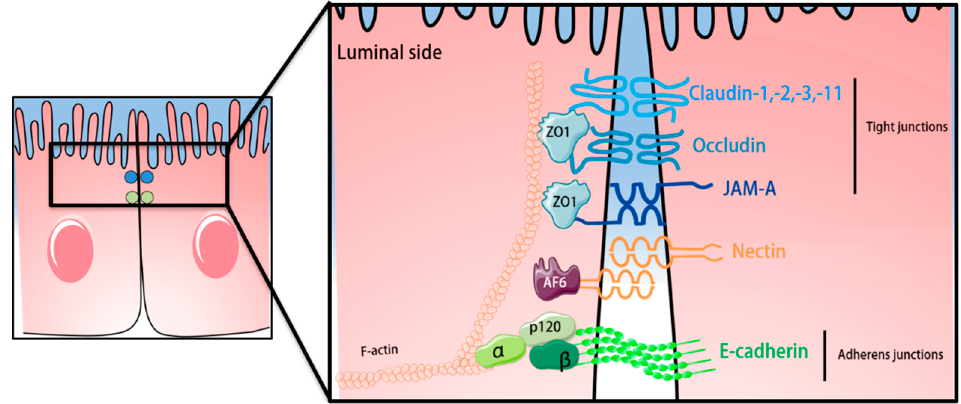
Figure 3. Schematic representation of the junctional complexes of the BCSFB at the choroid plexus. In similarity to the BBB, the proteins that compose the tight and adherens junctions of the choroid plexus BCSFB are connected to the cytoskeleton via intracellular scaffolding proteins and are localized in the apical part of the choroid plexus epithelial cells. The shapes of the proteins were adapted from Servier Medical Art (http://smart.servier.com/), licensed under a Creative Common Attribution 3.0 Generic License.